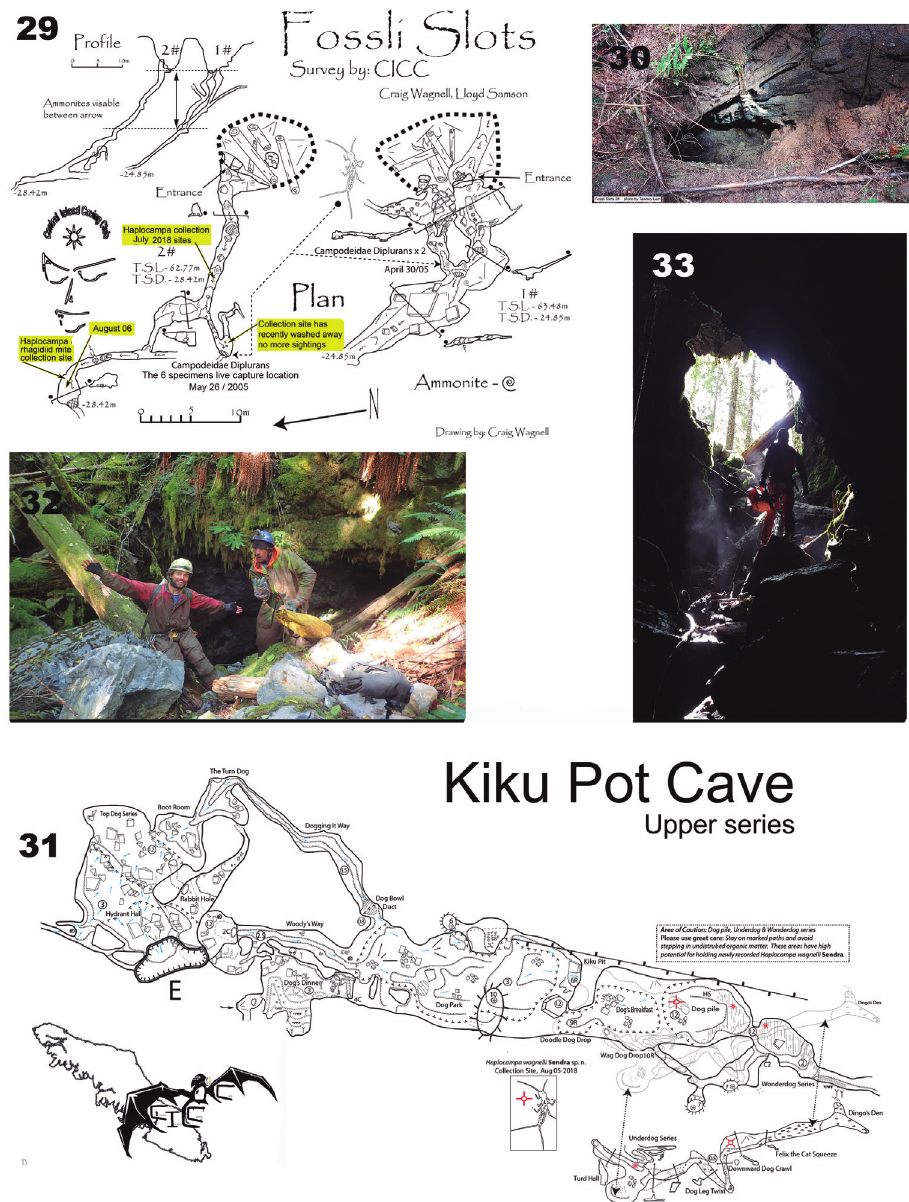
Figures 29–33. 29 Map of Fossli Slots caves with spots where Haplocampa wagnelli sp. n. was seen 30 en- trance of Fossli Slot #2 cave 31 Kiku Pot cave with spots where Haplocampa wagnelli sp. n. was seen 32 en- trance of Kiku Pot cave with Felix Ossigi-Bonanno and Craig Wagnell after the success finding 33 entrance of Kiku Pot cave viewed from inside the